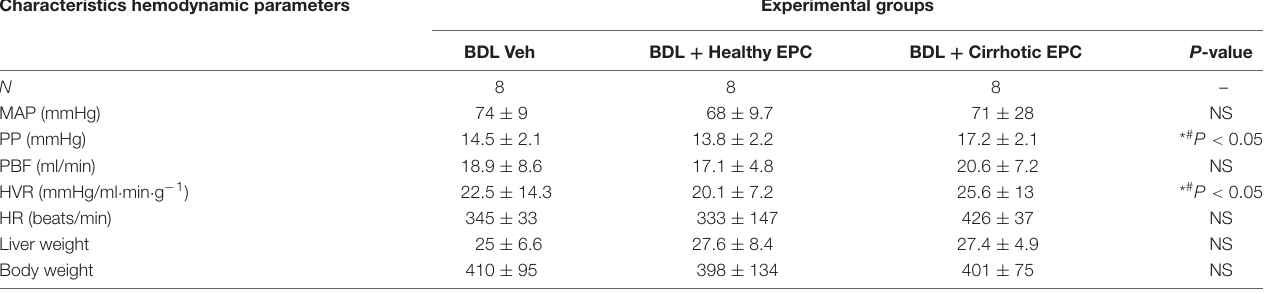
TABLE 3 | Hemodynamic parameters. Characteristics hemodynamic